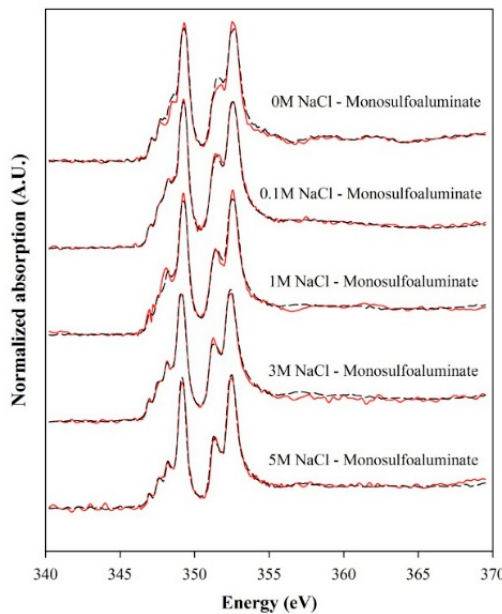
Figure 3. XANES spectra of the Ca L III , II -edge collected from monosulfoaluminate samples suspended in NaCl solutions. Solid lines are the measured XANES spectra. Broken lines are the LC fitted spectra.